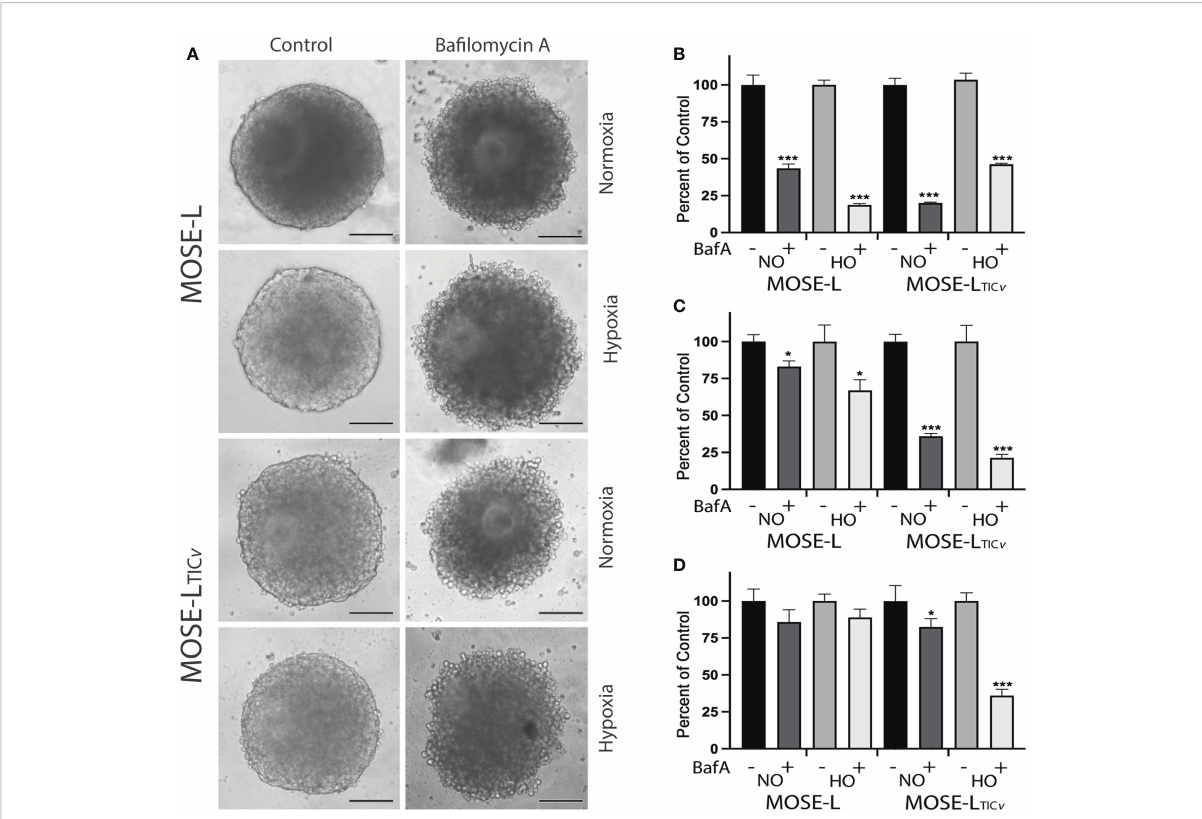
FIGURE 3 Inhibition of mitophagy affects cell viability. (A) Ba fi lomycin A1 (Baf1) treatment caused the deterioration of spheroids in normoxia (NO) and hypoxia (HO). (B) Adherent cells were treated with BafA1 for 24 h. (C) Reduced viability when cells were treated with BafA1for 24 h at time of seeding and (D) after the spheroids had formed. *p<0.05 and ***p<0.001 vs. untreated